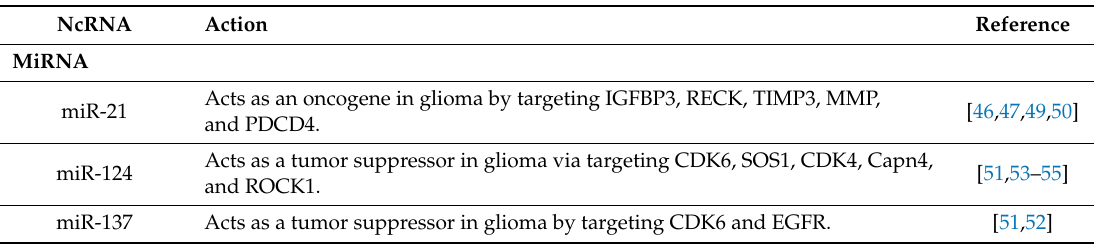
Table 2. Key functional ncRNAs (miRNA, lncRNA, and circRNA) in